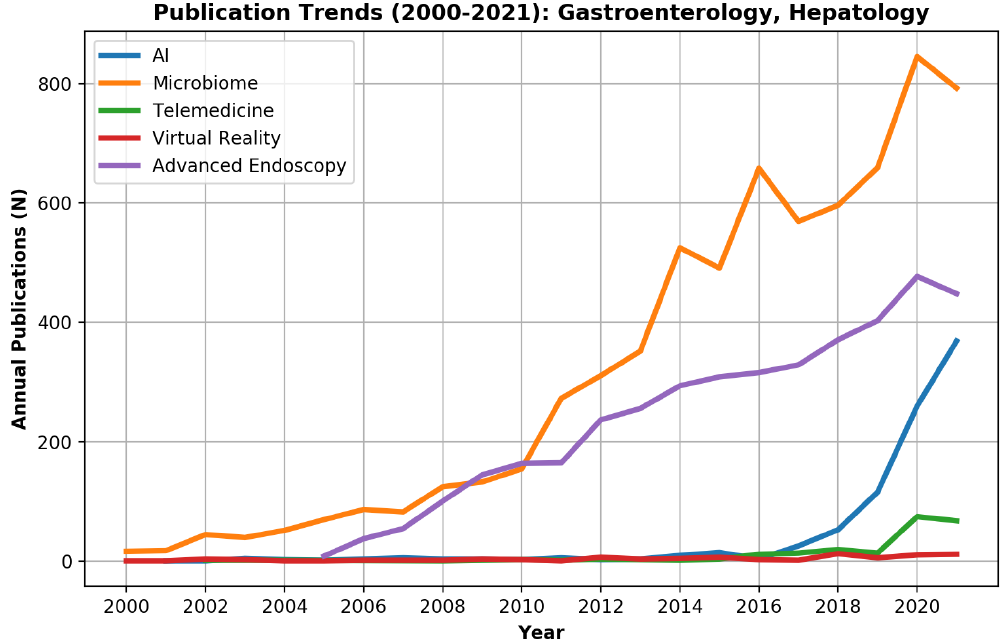
Figure 2. Publication trends of innovation research fields (artificial intelligence (AI), virtual reality (VR), telemedicine, the microbiome, and advanced endoscopy) in the gastroenterology field during 2000 – 2021.